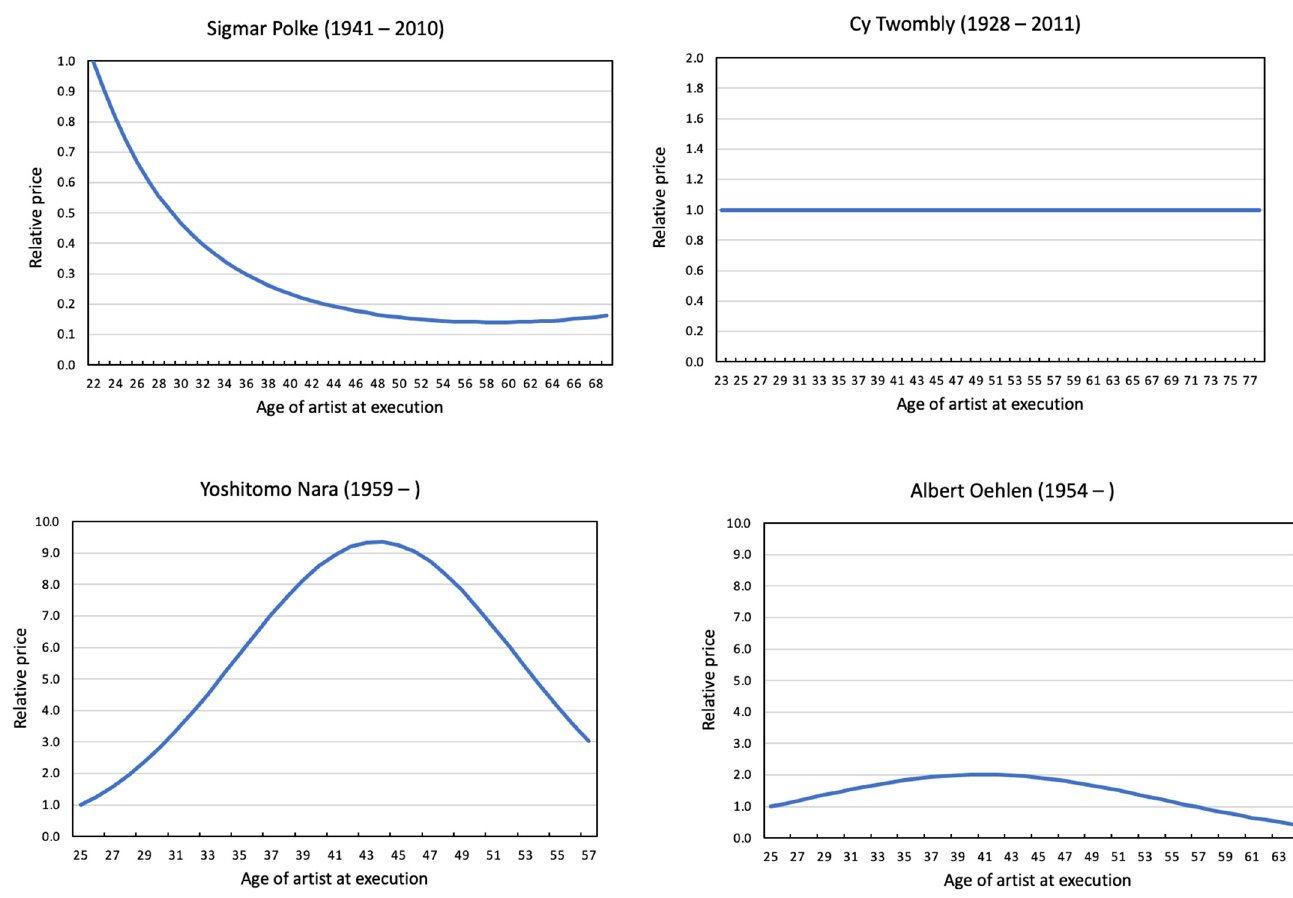
Figure 4. Relative prices for paintings executed at different ages by Yoshitomo Nara, Albert Oehlen, Gerhard Richter, and Christopher Wool.